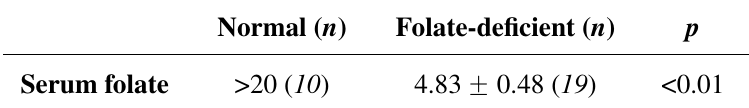
Table 2. Serum folate levels (ng/mL) in the pregnant mice (mean ˘ standard error of the mean